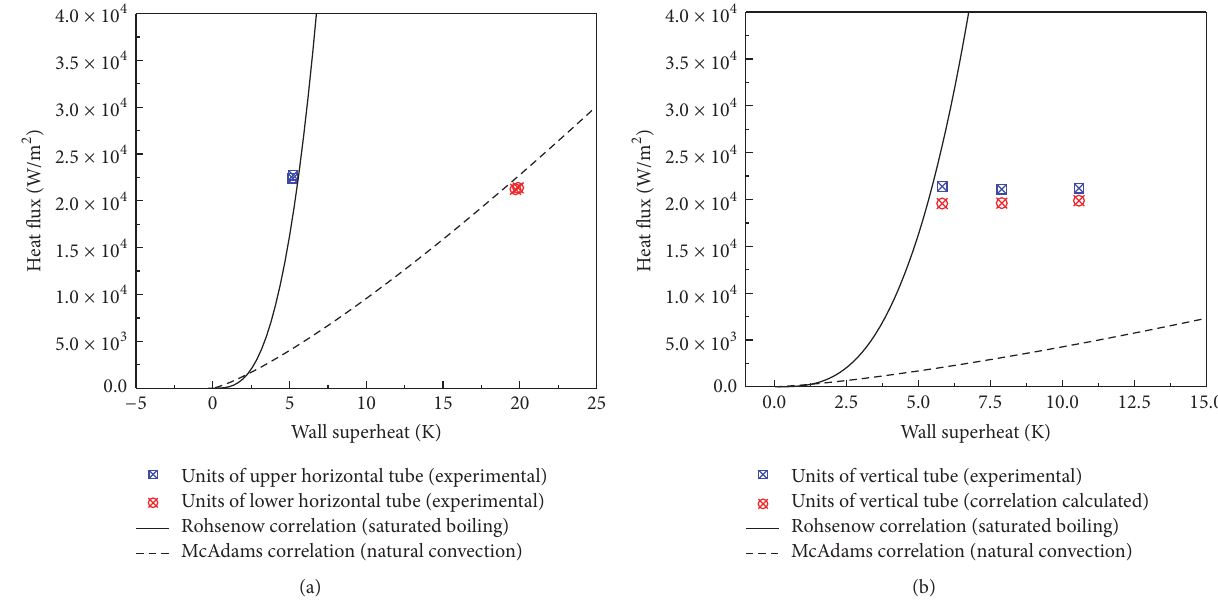
Figure 8: Comparison of experimental heat flux with the experience formulation at 12100 s. (a) Comparison of heat flux in horizontal cells. (b) Comparison of heat flux in vertical